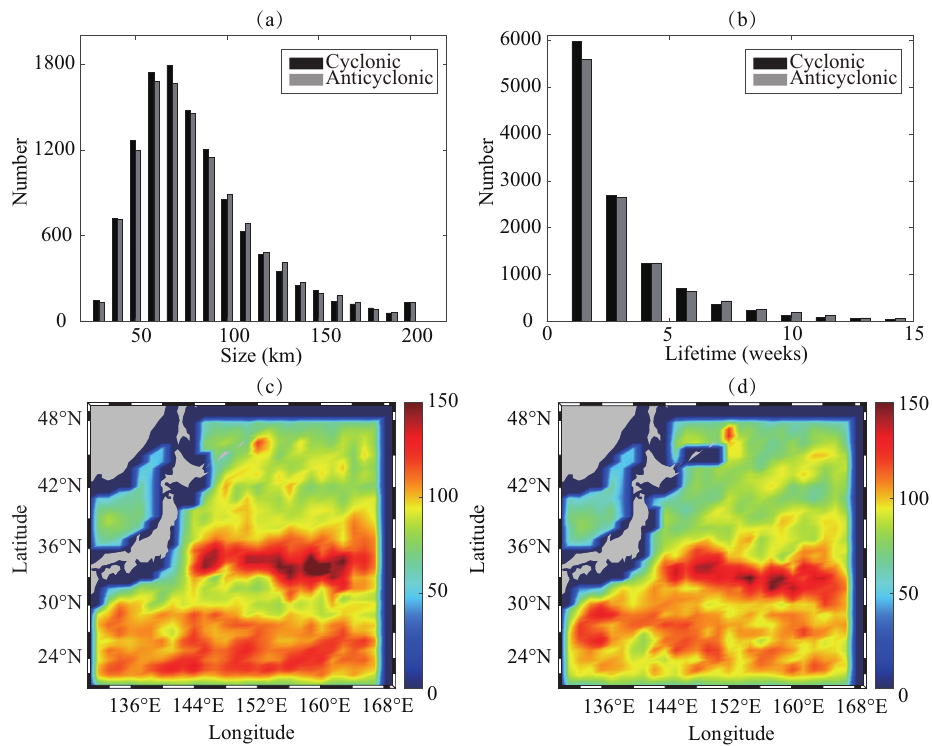
Figure 4. Statistical results of cyclonic and anticyclonic near Kuroshio obtained from 20 years of assimilation data from 1993 to 2014 ( a ) Kuroshio Current size ( b ) Kuroshio Current lifetime, ( c ) cyclonic size distribution and ( d ) anticyclonic size distribution.